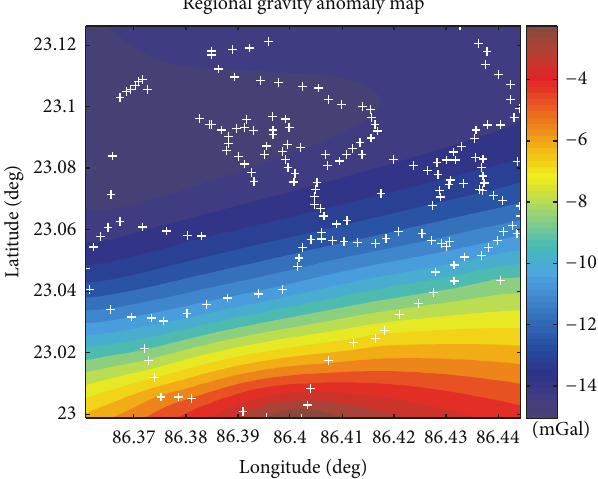
Figure 3: Regional gravity anomaly map of the study area after 3rd degree trend surface fitting to Bouguer anomaly. Plus (+) symbols are the gravity survey